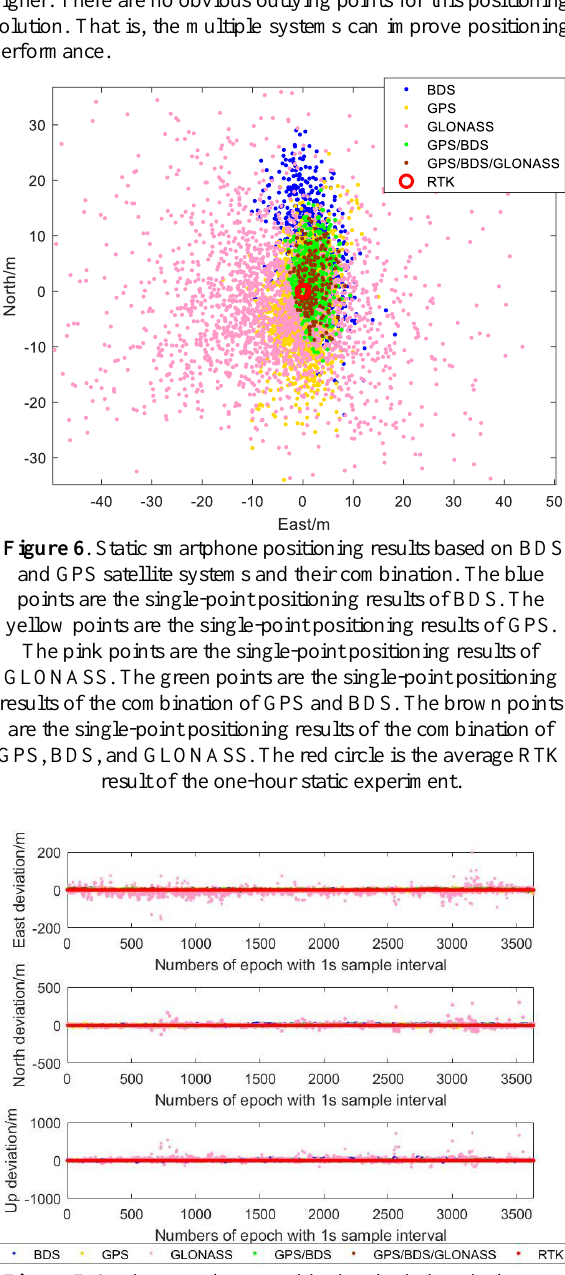
Figure 7 . Static smartphone positioning deviations in the east, north, and up directions based on BDS and GPS satellite systems and their combination. The blue points are the single- point positioning results of BDS. The yellow points are the single-point positioning results of GPS. The pink points are the single-point positioning results of GLONASS. The green points are the single-point positioning results of the combination of GPS and, BDS. The brown points are the single-point positioning results of the combination of GPS, BDS and GLONASS. The red points are the RTK results of the one-hour